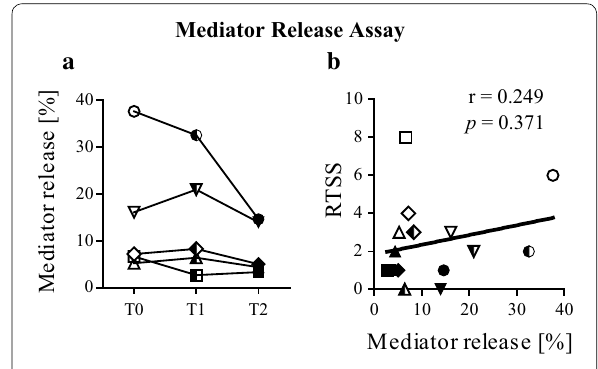
Fig. 4 Bet v 1-specific β-hexosaminidase release during AIT analyzed by mediator release assays. a Therapy-related changes in mediator release triggered by 10 ng/ml Bet v 1. Statistics were performed with Friedman and Dunn’s post test. b Correlation of mediator release with RTSS. Serum samples were obtained at three different time points (T0, open; T1, semi-filled; T2, filled